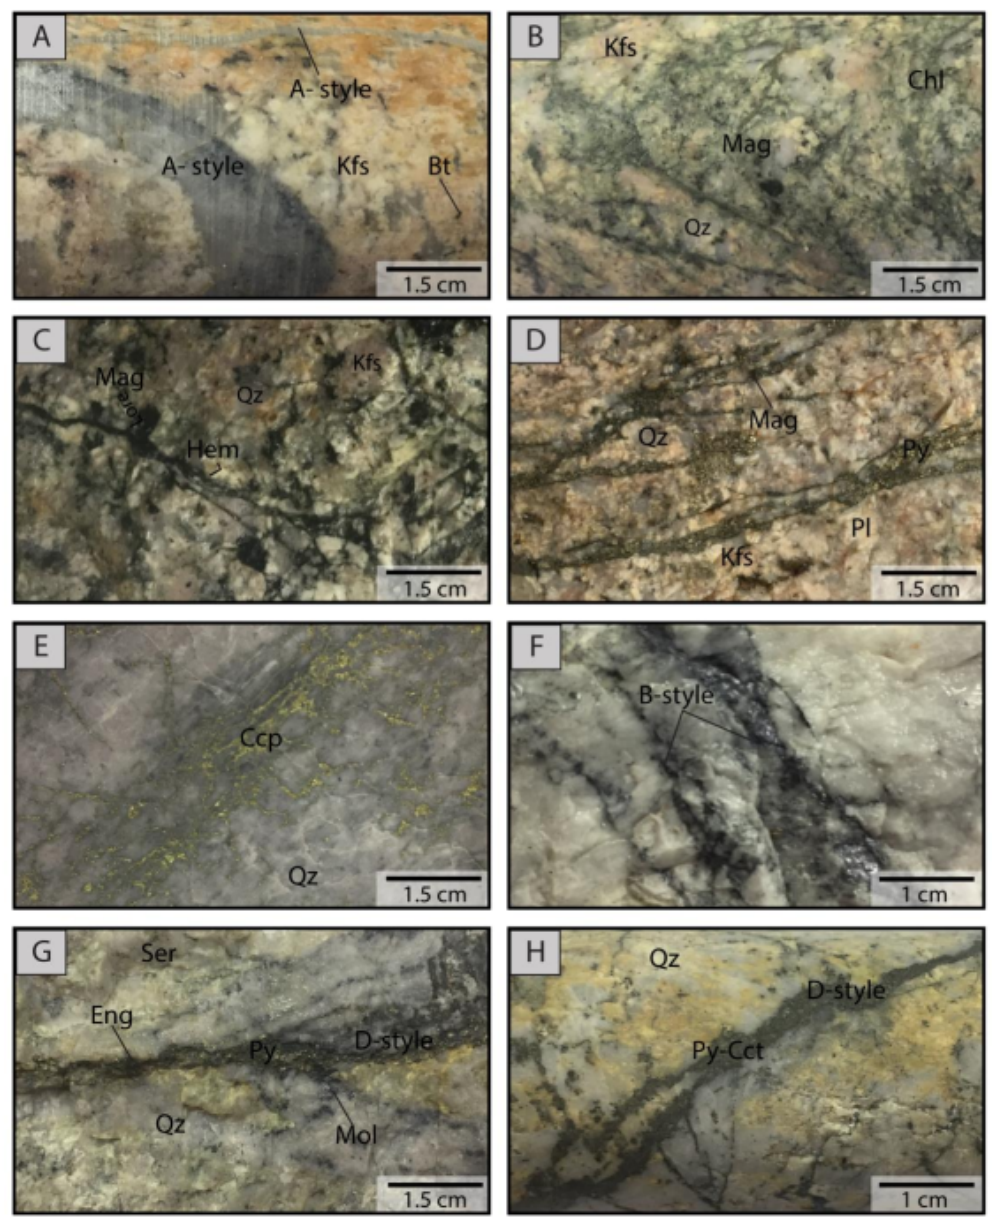
Figure 4. Photographs of main veinlet-types recognized at the Chuquicamata Underground mine. ( A ) “A-type” veinlets with quartz and a halo of biotite; ( B ) Chlorite veinlets with magnetite cross-cutting K-feldspar alteration; ( C ) Hematite veinlets with magnetite; ( D ) Pyrite veinlets with chlorite and magnetite associated with chloritic alteration; ( E ) Chalcopyrite veinlets; ( F ) “B-type” veinlet composed of quartz and molybdenite; ( G ) “D-type” veinlet with pyrite-quartz-molybdenite- enargite; ( H ) “D-type” veinlet with pyrite-chalcocite. Cct: Chalcocite, Chl: Chlorite, Ccp: Chalcopyrite, Eng: Enargite, Hem: Hematite, Kfs: K feldspar, Mag: Magnetite, Mol: Molybdenite, Pl: Plagioclase, Py: Pyrite, Qz: Quartz, Ser: